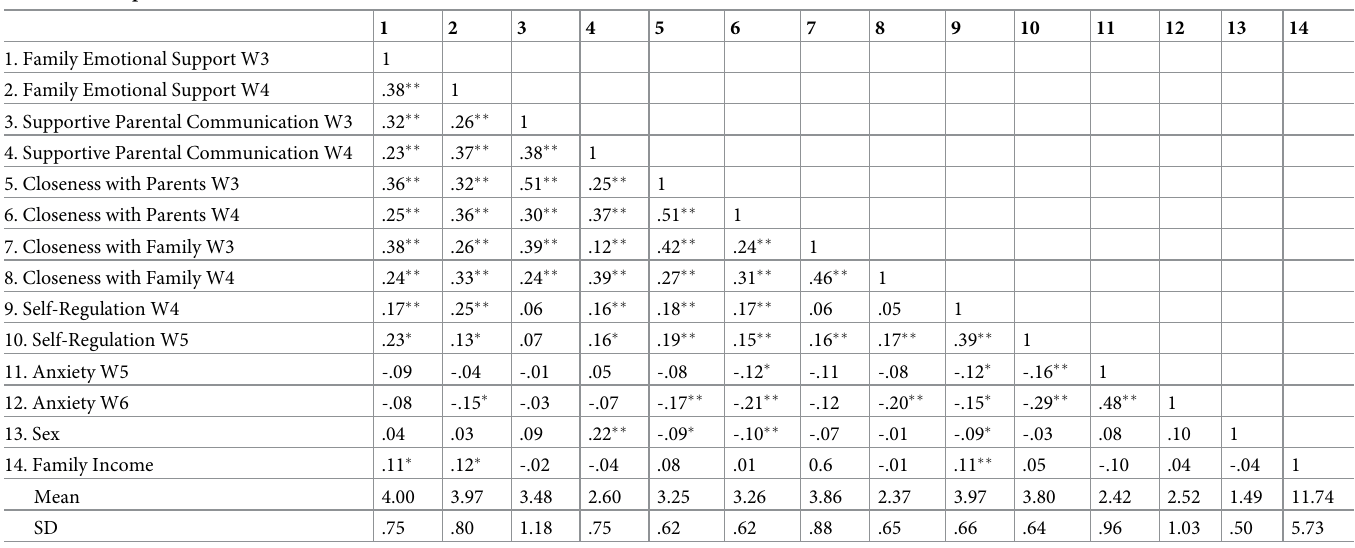
Table 1. Descriptive statistics and bivariate correlations.